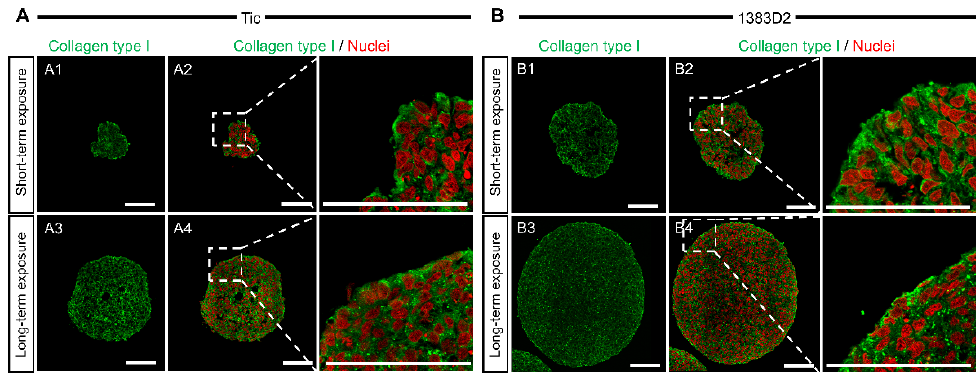
Figure 3. The effect of ROCK inhibitor on collagen type I localization in cell aggregates of two different hiPSC lines (( A ), Tic; ( B ), 1383D2) under short- and long-term exposure conditions. Florescent images of collagen type I at 120 h showing nuclei (red) and collagen type I (green) ( A1 – B4 ). Scale bars, 100 μ m.